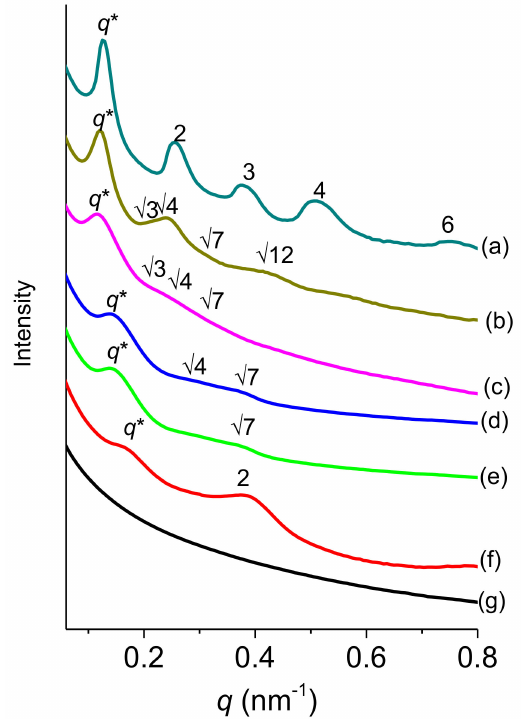
Figure 9. SAXS analyses of PS- b -PVPh/PEO- b -P4VP mixture at room temperature of (a) 0/100, (b) 10/90, (c) 30/70, (d) 50/50, (e) 70/30, (f) 90/10, and (g)